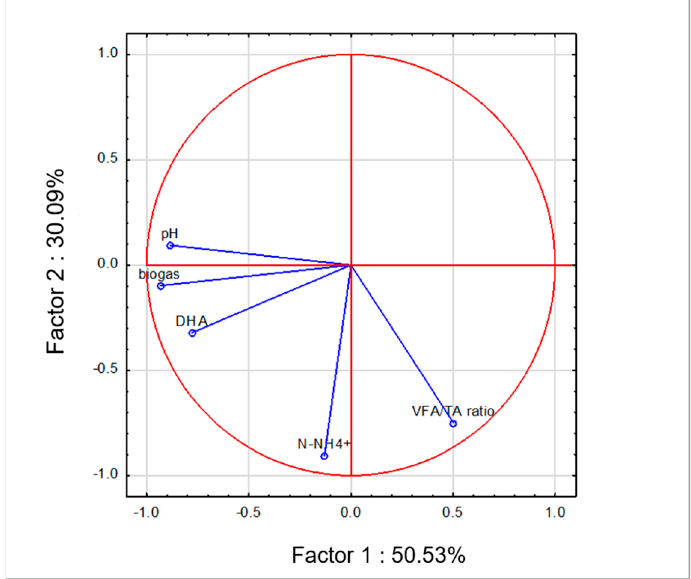
Figure 8. Distribution of bacteria activity and chemical parameters in two PCA axes. Legend: DHA—dehydrogenase activity, VFA/TA ratio—volatile fatty acids-to-total alkalinity ratio ,